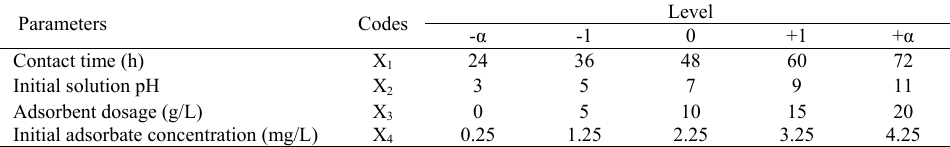
Table 1: Experimental levels and representative codes of independent variables Parameters